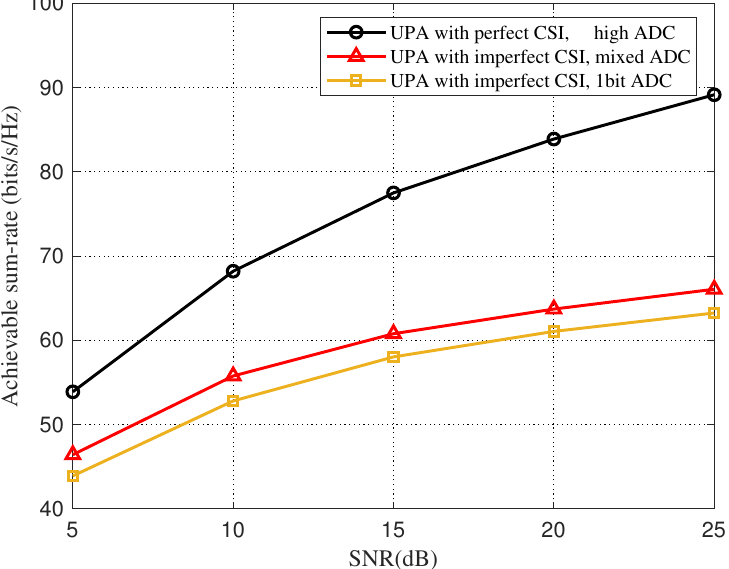
Figure 7. Total rate for beam selection against different SNR for the beamspace channel